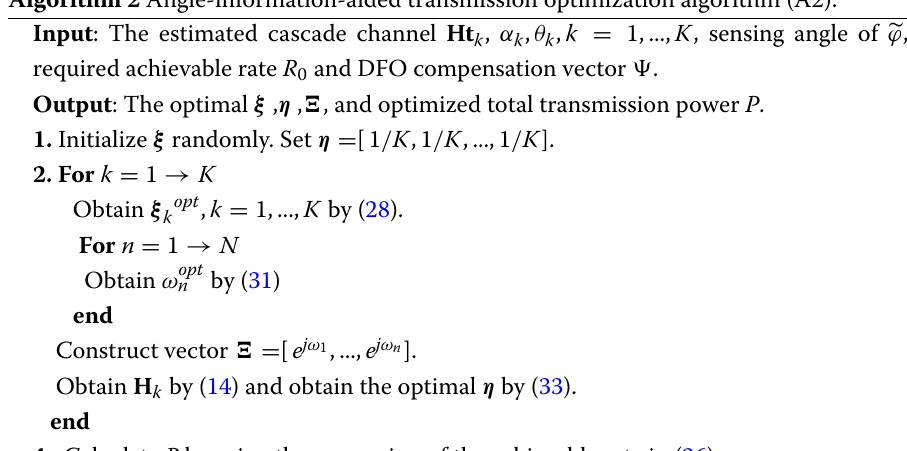
Algorithm 2 Angle-information-aided transmission optimization algorithm